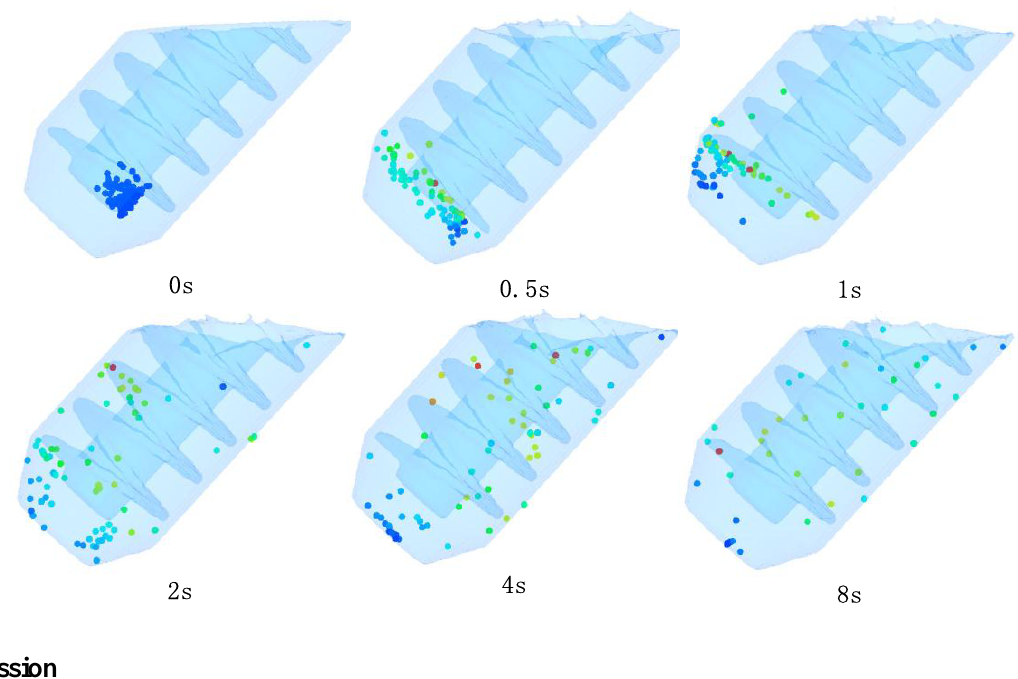
Figure 11. Distribution of the particles in the melt at different